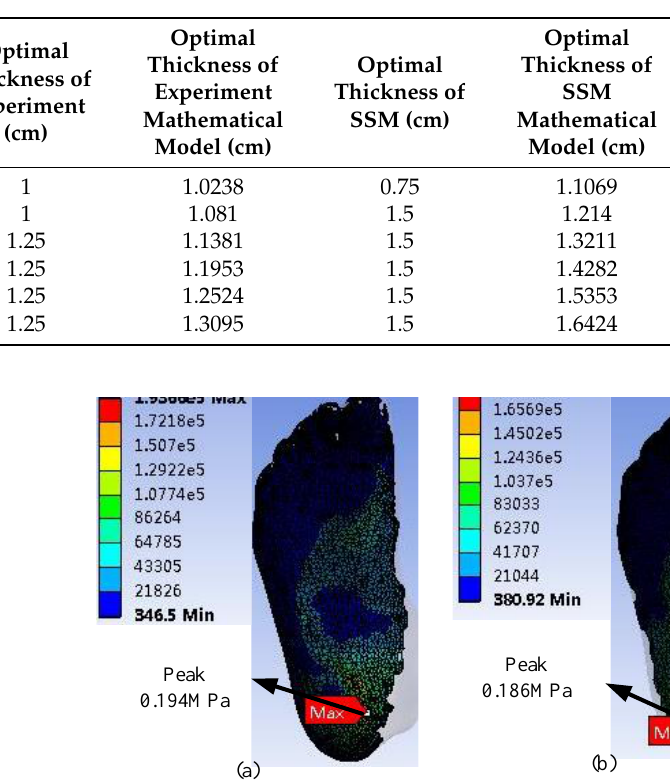
Table 3. Data on the relationship between different insole thicknesses and plantar pressures under human body weight in the WM.